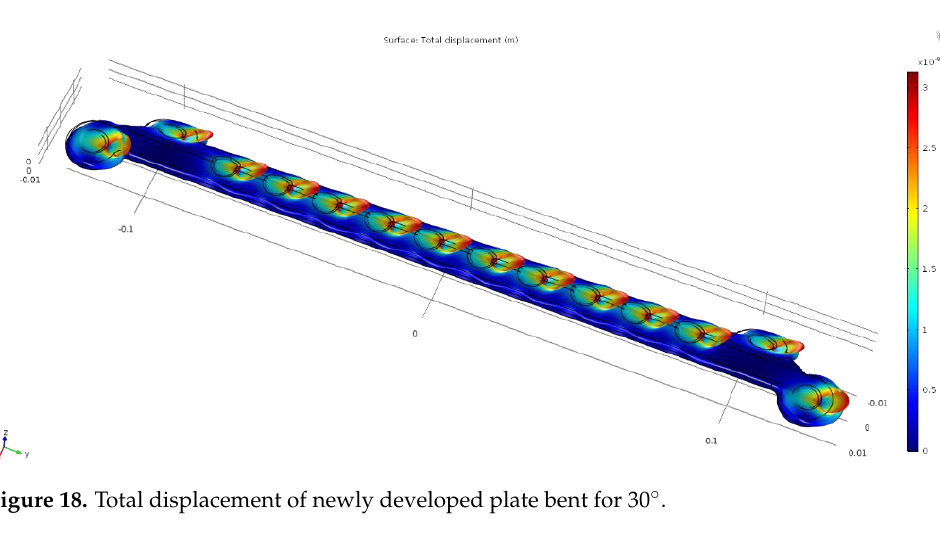
Figure 17. First principal strain of newly developed plate bent for 20°.